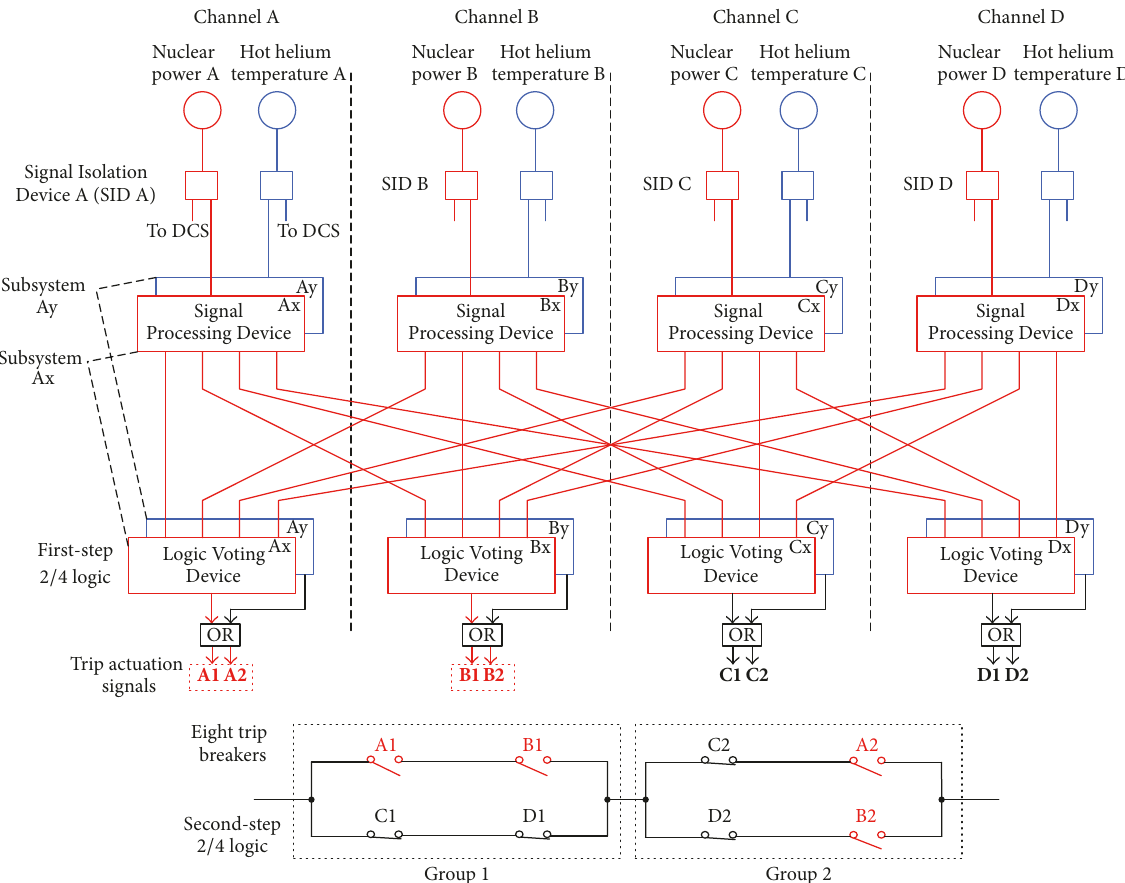
Figure 2: An example for the grouping of protection variables in two subsystems of one